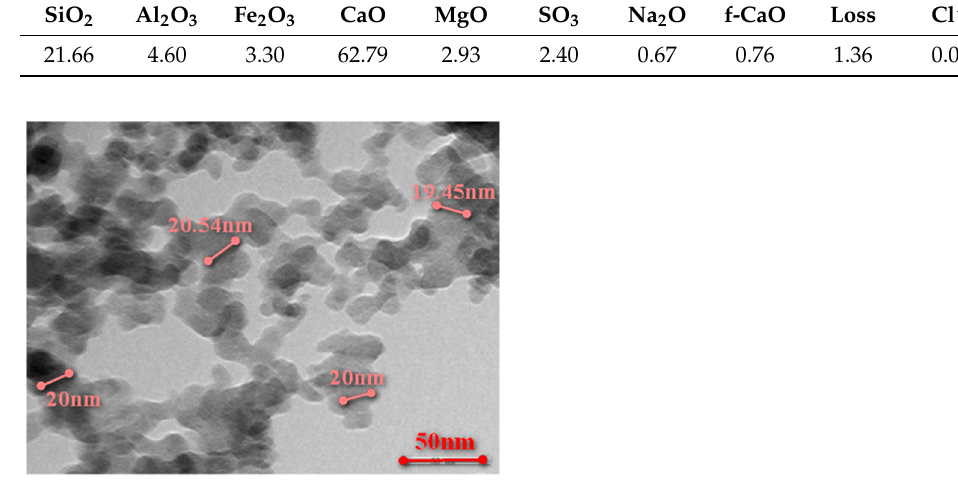
Figure 1. TEM image of the NSN.